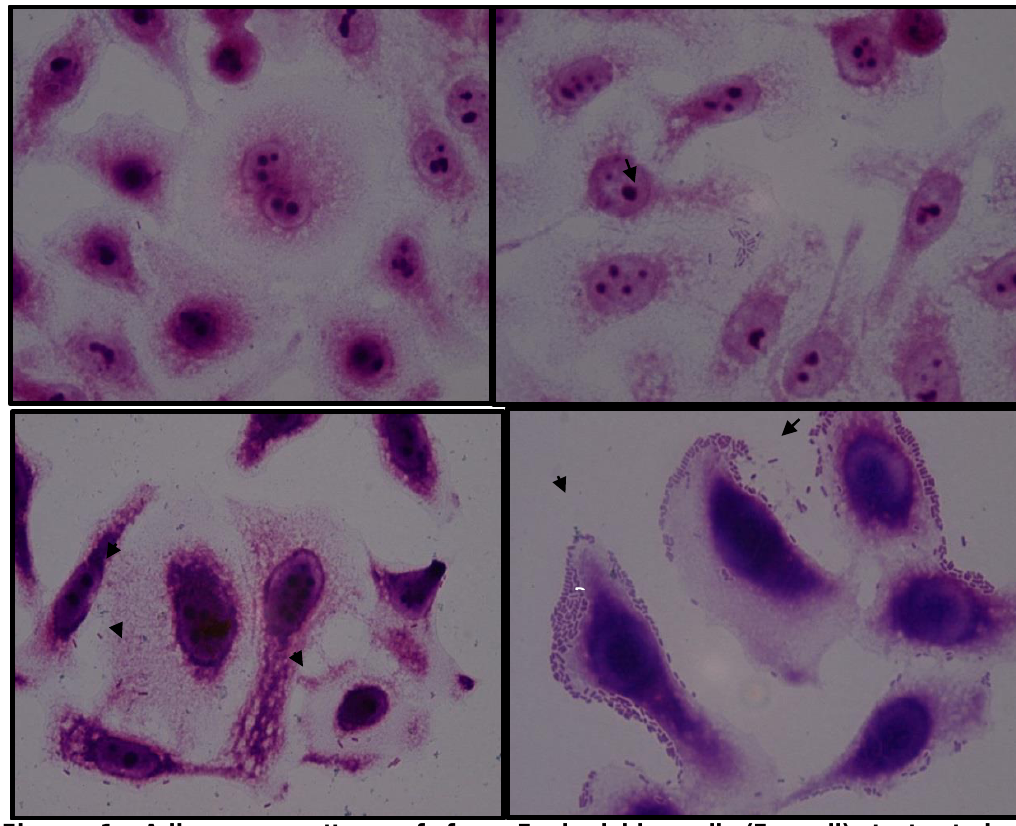
Figure 1. Adherence pattern of four Escherichia coli (E. coli) test strains: A) Non-adherent, B) Localised adherence, C) Diffuse adherence, D) Aggregative adherence, using light microscopy X1000 (arrows show adhered E.